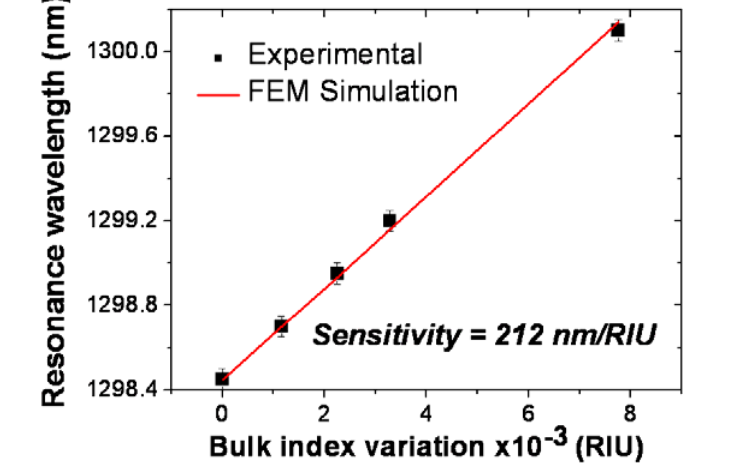
Figure 3. Resonance wavelength of the Si of the bulk (top cladding) refractive index variation. Black dots: experimental data (water- ethanol solutions) [12]; red line: finite element method (FEM) based calculations